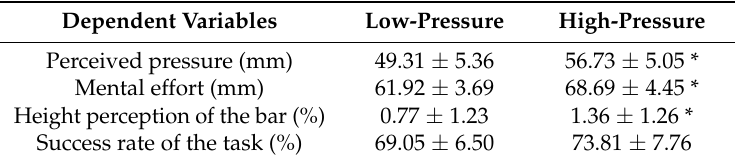
Table 1. Means and standard errors of all dependent variables in the low-pressure and the high-pressure